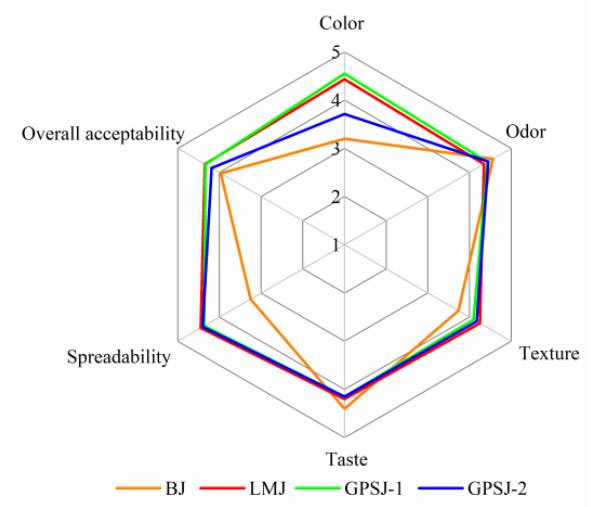
Figure 6. Sensory evaluation of blueberry jam samples.